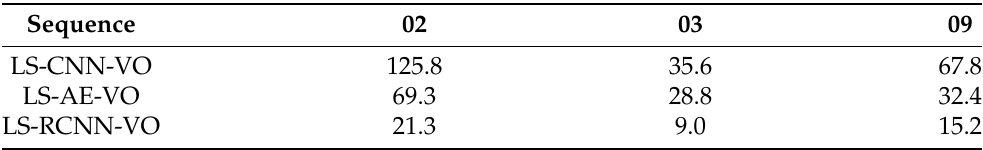
Figure 9. Comparison of the moving trajectories detected by the three models with the ground truth for sequence 02 ( a ), 03 ( b ), and 09 ( c ) of Malaga dataset. Table 3. Comparison of absolute translation root mean square error (AT-RMSE) (m) of the three models on the Malaga